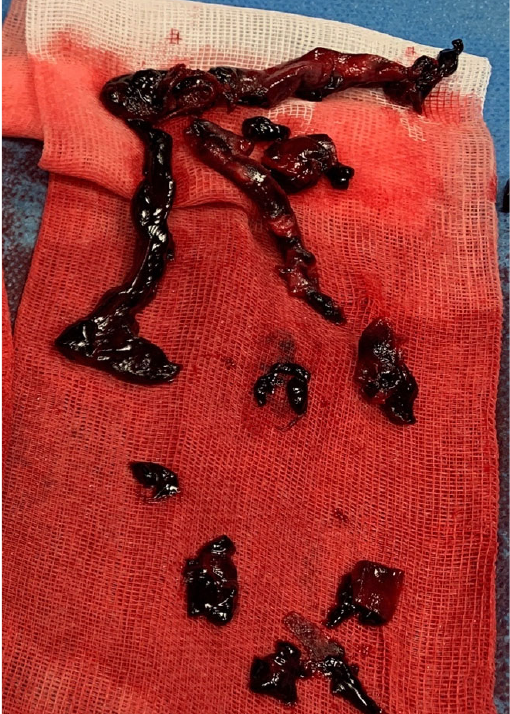
Figure 4. Fresh and organized thrombotic material retrieved via direct percutaneous, pulmonary thrombus aspiration.